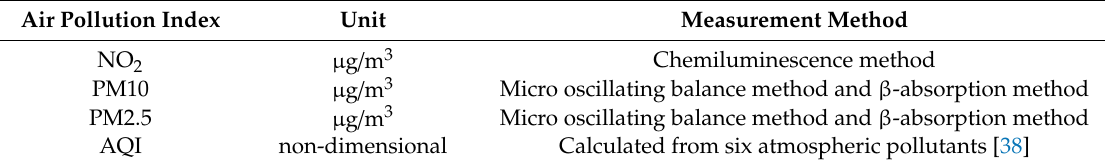
Table 1. The brief description of the measurement systems to measure the air pollution indexes.